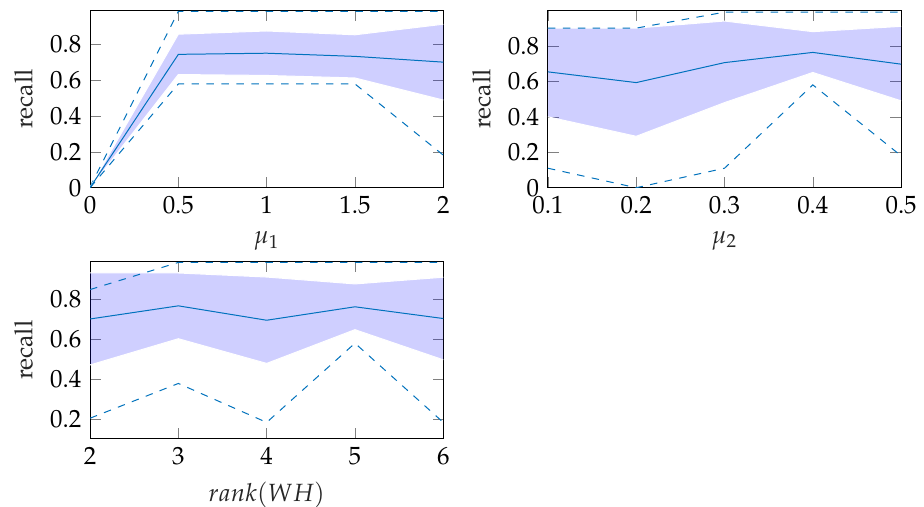
Figure 13. Robustness of windowing parameters, where the dashed lines show the minimum and maximum recall values and the standard deviation is indicated by the filled